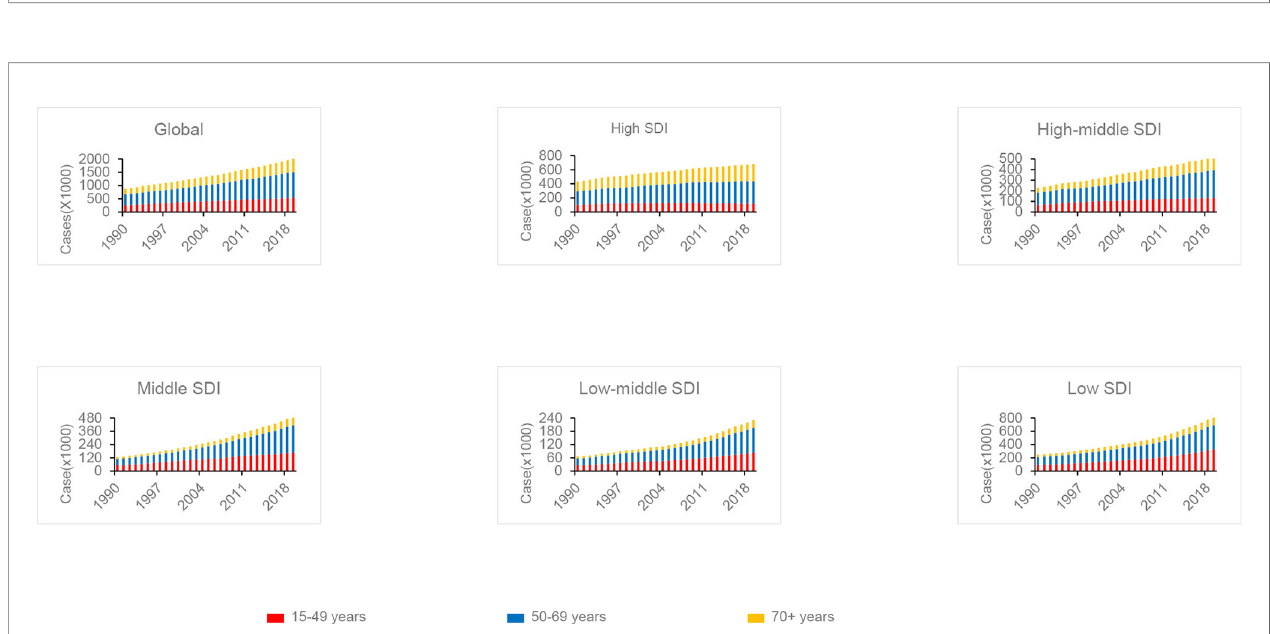
FIGURE 3 | Age-standardized incidence rates (ASIR) of breast cancer by 204 countries and territories and Socio-Demographic Index (SDI), 2019; expected values are shown as the black line. Each point shows observed ASIR for speci fi ed country in 2019. The R indices and P value were derived from Pearson correlation